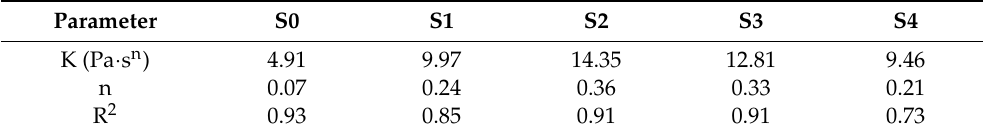
S0—mayonnaise without BPP, control; S1—mayonnaise with 1.5% BPP; S2—mayonnaise with 3% BPP;